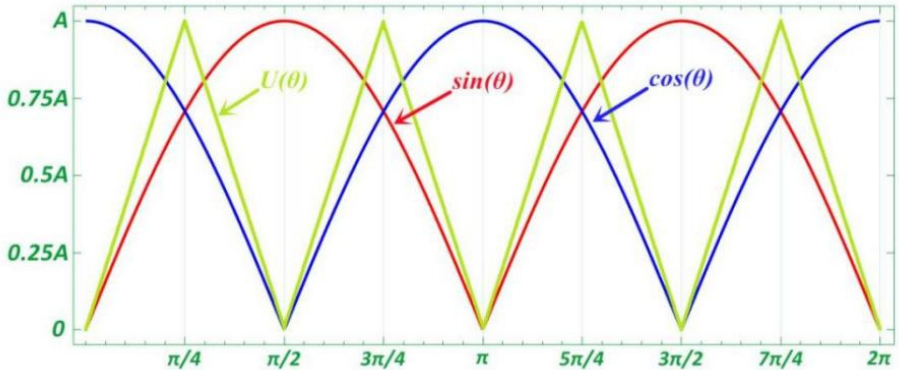
Figure 5. Comparison among original signals and constructed function.